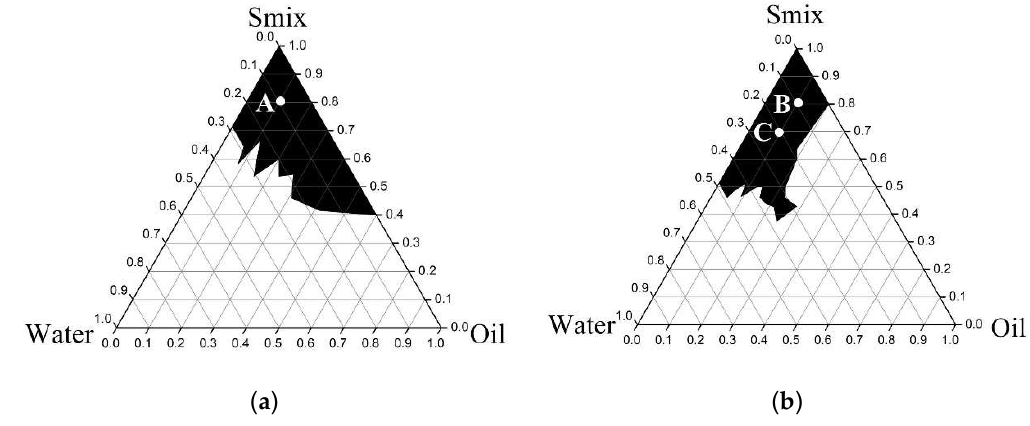
Figure 7 . ( a ) Formulation A composing of CA / Tween 85 and ethanol / water, when the Smix ratio was 4 : 1; ( b ) Formulation B and C composing of CA / Tween 85 and propylene glycol / water, when the Smix ratio was 2 : 1 .